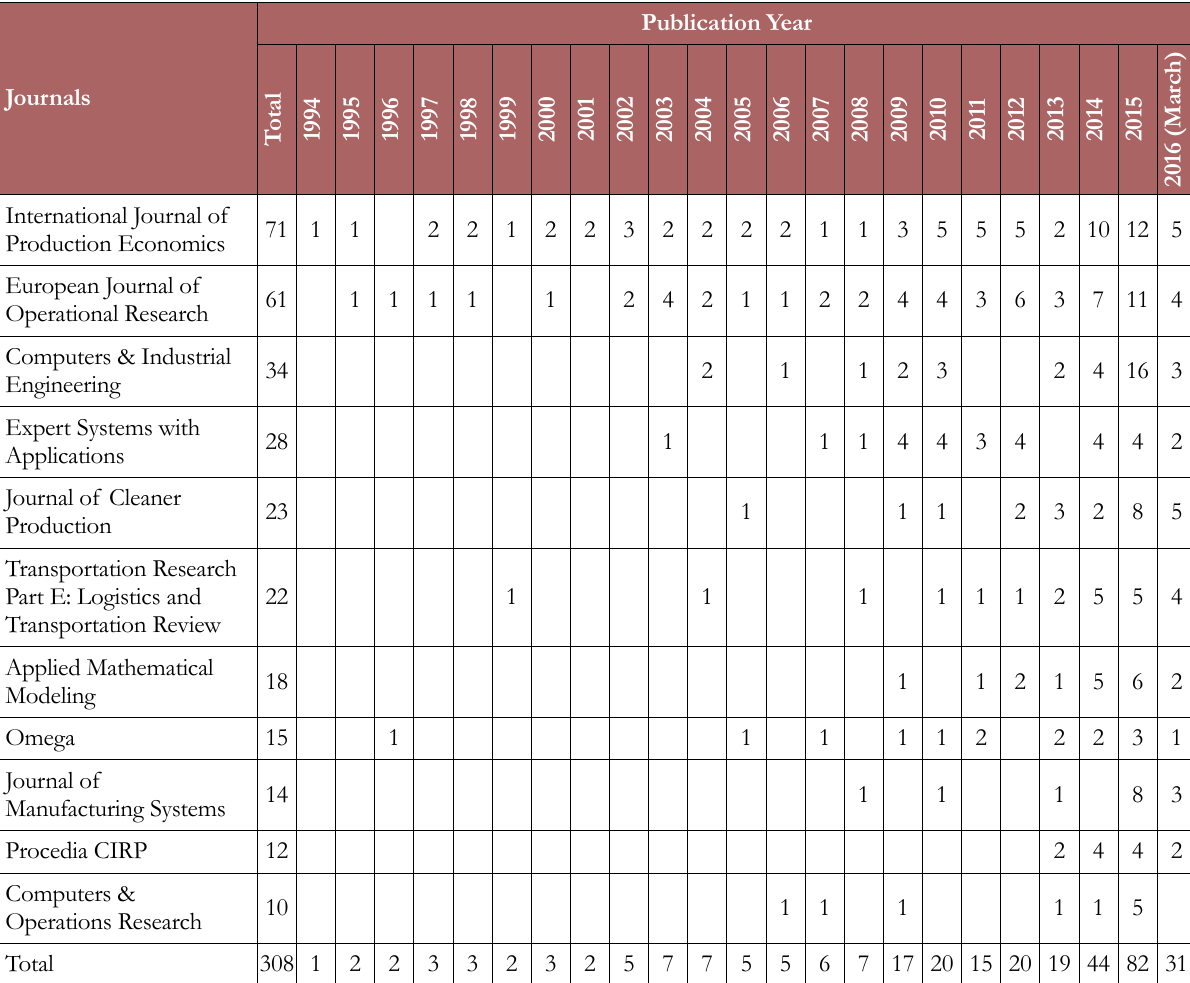
Table 3. The 11 top journals with 10 or more publications in location facility in supply chain management